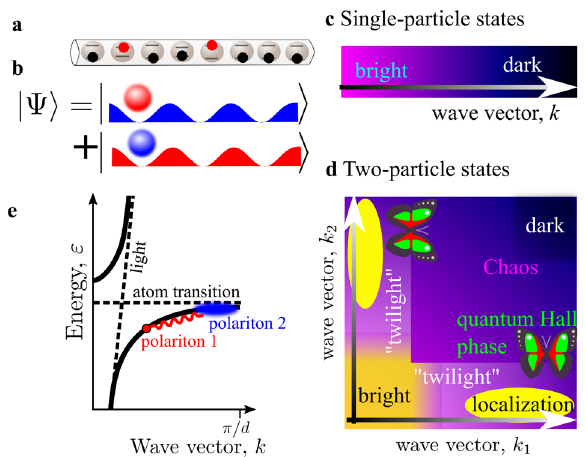
Fig. 1 Emergence of two-polariton quantum phases from inter- actions. a Double-excited one-dimensional array of two-level atoms (qubits) in a waveguide. b Two-polariton quantum states where each indistinguishable polariton induces a potential for the other one. c and d Classi fi cation of single- and double- excited states of the atomic array depending on the wave vector of the excitations. Butter fl ies in d indicate the regions where the quantum Hall phase and Hofstadter-like butter fl y spectrum emerge from the interaction of two excitations. Regions of “ twilight ” states 47 and interaction- induced localization 48 are also shown. e Single-particle polariton dispersion. Interaction of a lower-branch polariton with small k and that with large k is